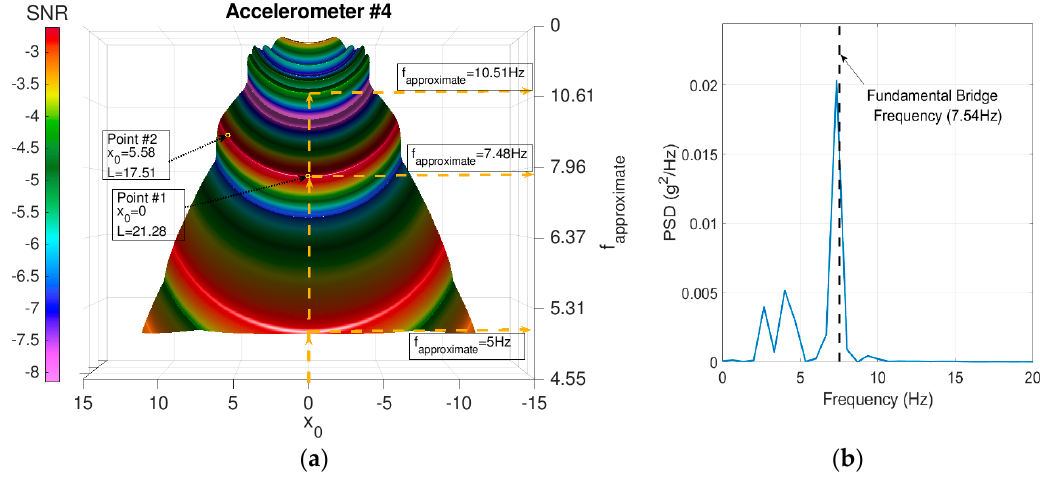
Figure 18. Test 3 results ( a ) FI-UPSR surface plot. ( b ) PSD for the extracted signal at f approximate = 7.48 Hz. Three dominant peaks are observed in the surface plot. The peaks at 5 Hz and 10.5 Hz indicate the frequencies of the vehicle. The third peak refers to the first fundamental frequency for the bridge (the peak at f approximate = 7.48 Hz). To extract the bridge signal, we manually selected the potential